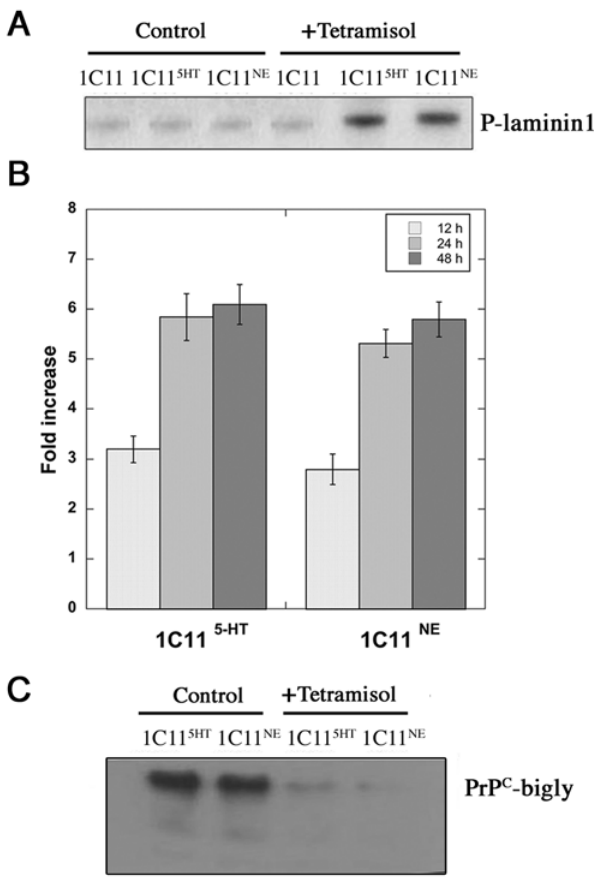
Figure 9. TNAP modulates laminin phosphorylation and binding to PrP C in 1C11 5-HT and 1C11 NE differentiated cells. The phosphorylation level of Laminin 1, isolated from spent medium of undifferentiated 1C11 cells or its neuronal 1C11 5-HT serotonergic and 1C11 NE noradrenergic derivatives pre-incubated with [ c - 32 P]-ATP, was detected by autoradiography as shown in (A) for untreated cells (control) or at 48 h upon TNAP inhibition with tetramisol ( + tetramisol (2.5 mM)). In (B) the fold increase of phopho-laminin in tetramisol treated vs untreated cells was quantified at different times with a PhosphorImager and the values correspond to the mean of three independent experiments. (C) Laminin-1 was immunoprecipitated from 1C11 5-HT serotonergic and 1C11 NE noradrenergic cells left untreated (left) or treated for 24-hr with 2.5 mM tetramisol (right) and immunodetection was carried out with anti-PrP antibodies